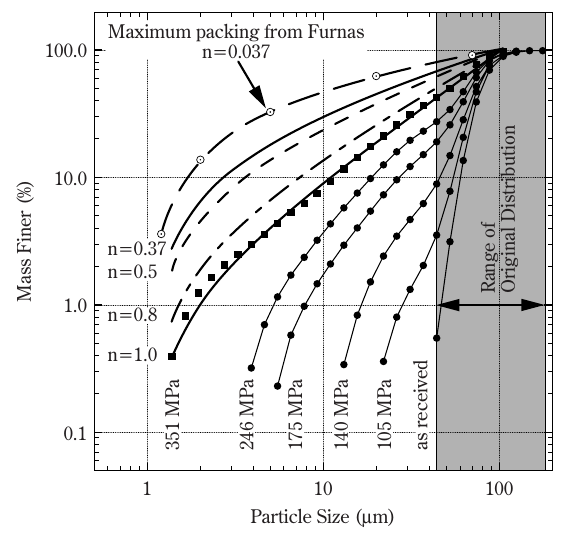
Fig. 9 As pressure is increased, the size distribution of com- pacted spheres approaches the Dinger-Funk distribution (Eqn. 8) with exponent n (cid:2) 1. Maximum packing is pre- dicted by Dinger and Funk when n (cid:2) 0.37. Maximum pack- ing is predicted by Furnas when n (cid:2)